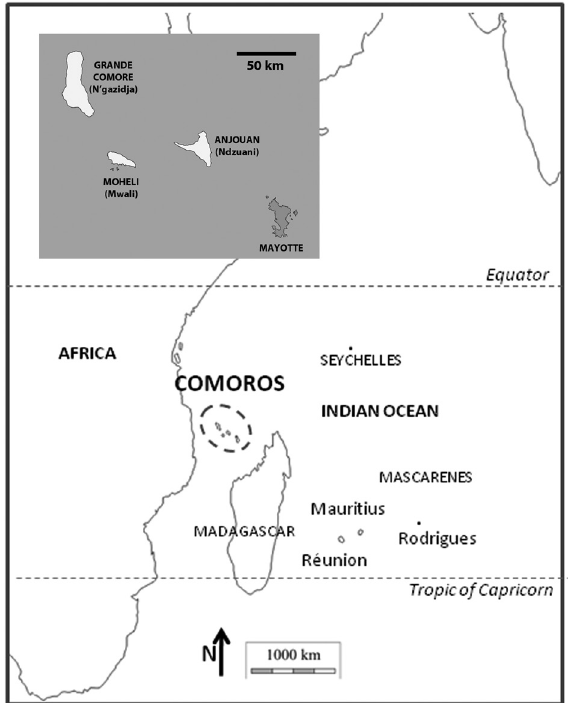
Fig. 1. Location of the Comoros archipelago in the western Indian Ocean; close-up on the four islands in grey inset; islands in white form the Union of Comoros, Mayotte in grey is a French overseas